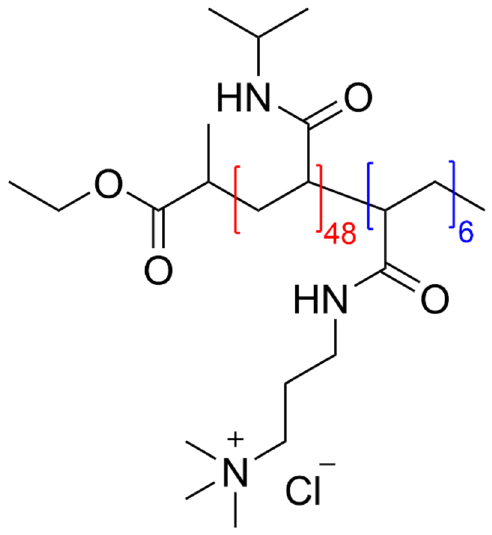
Figure 1. Chemical structure of PNIPAAM 48 -b-PAMPTA 6 (+).